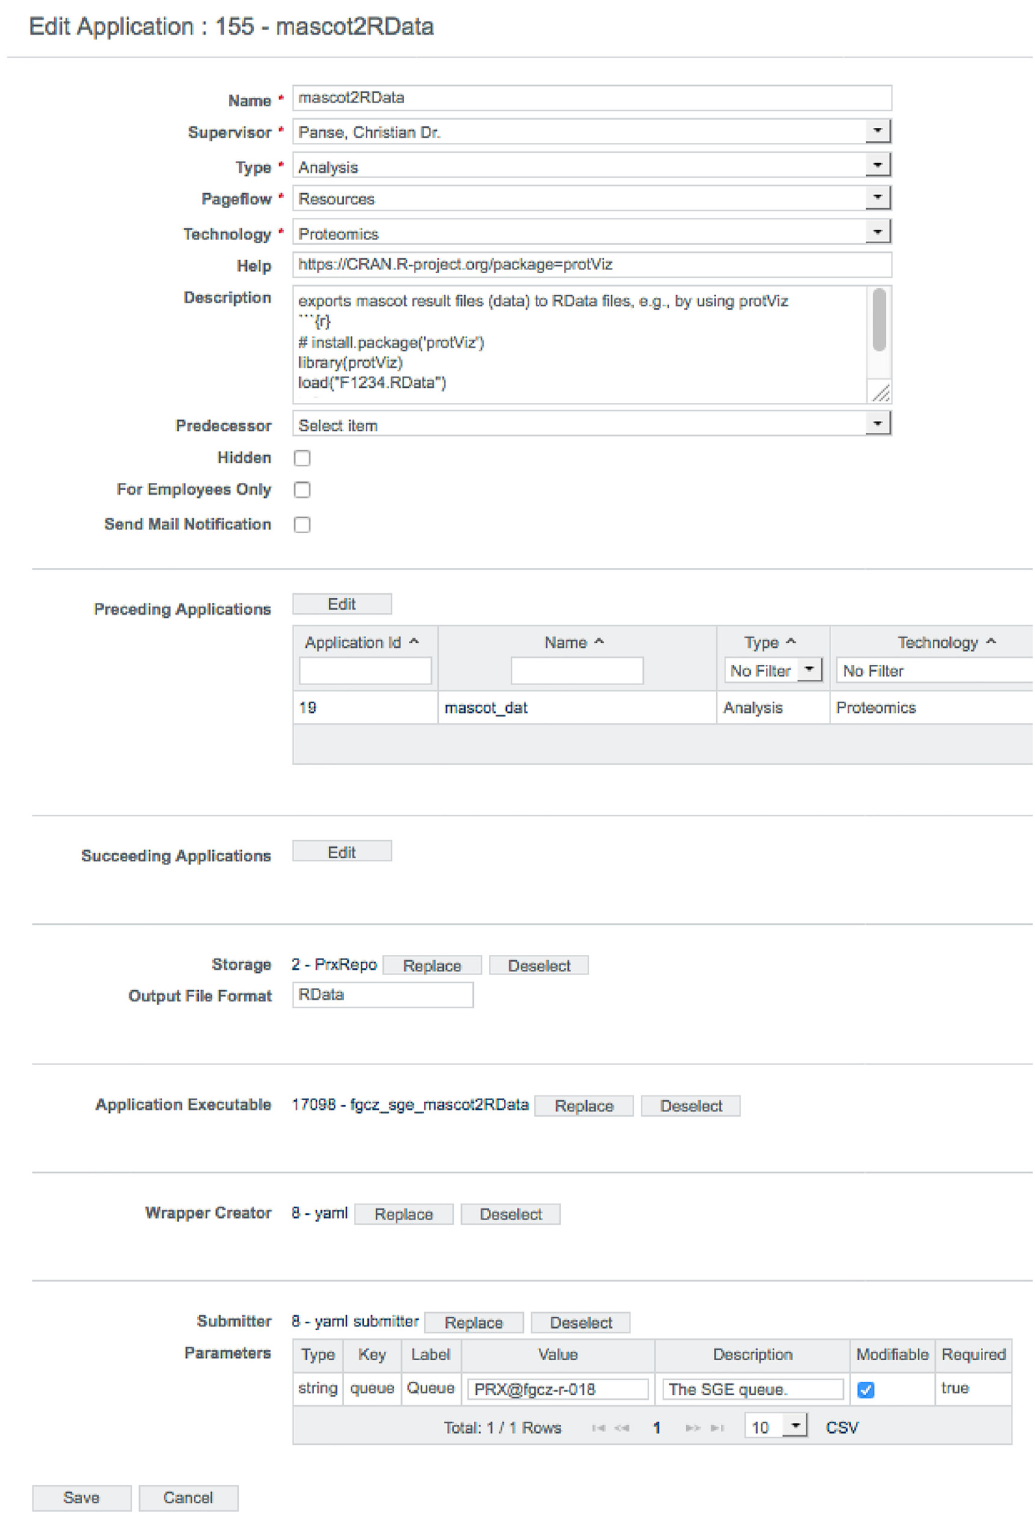
Figure 5: Application configuration screen of the B-Fabric